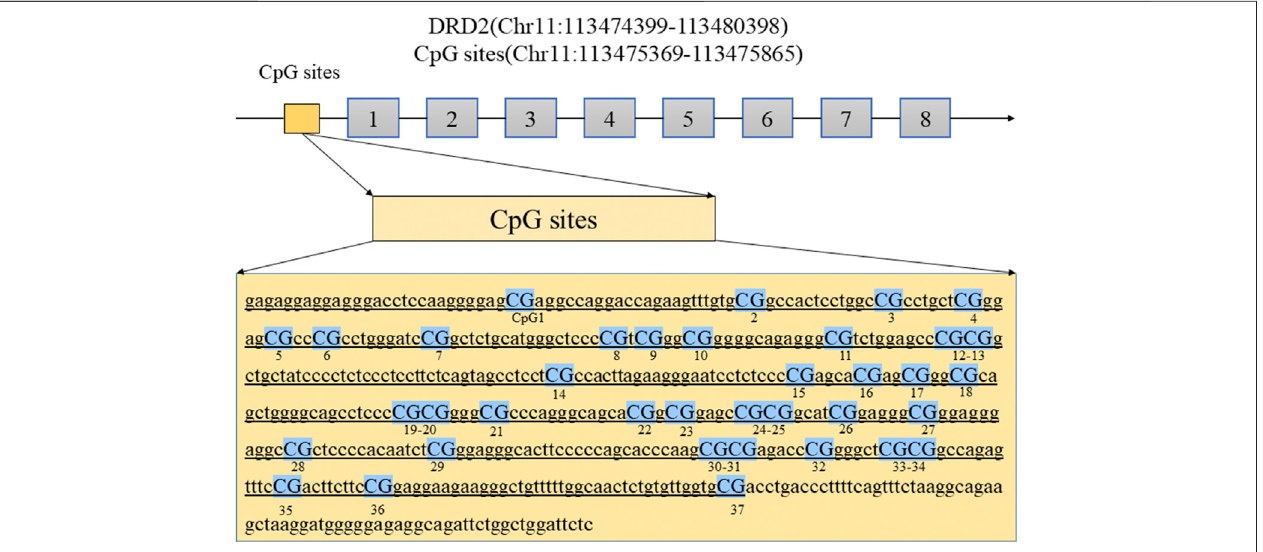
FIGURE 1 | The diagram shows the location of the DRD2 promoter regions analyzed in this study. Abbreviations: DRD2, dopamine receptor D2 gene.